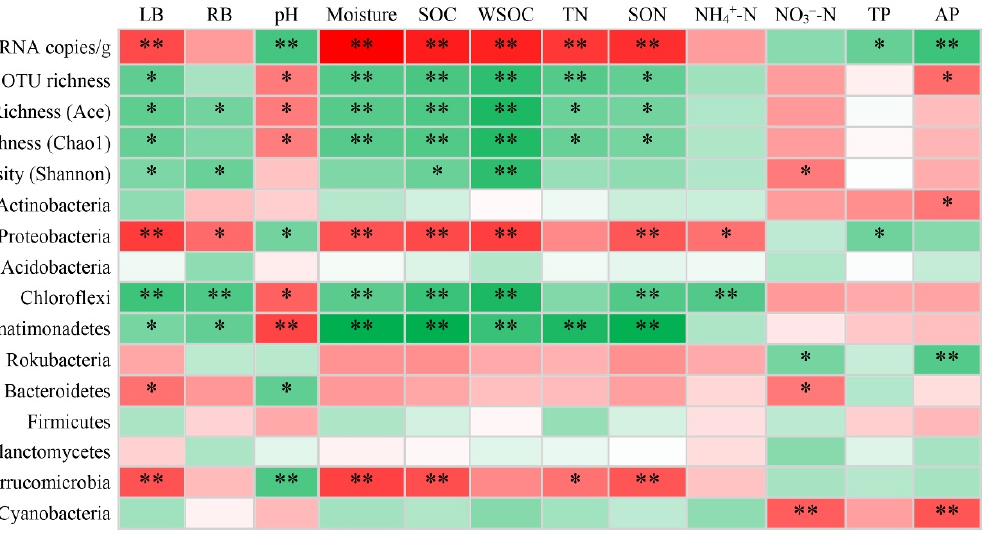
Figure 7. Pearson correlations coefficients between bacterial abundance, diversity, and community composition, and the environmental variables ( n = 4) between successional stages on the Loess Plateau of China. Red indicates positive correlations, while green indicates negative correlations. The darker color, the stronger the correlation. * p < 0.05, ** p < 0.01.